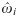
Model fit for GTEx summary statistics selects directional annotations mainly from biologically consistent cell types.Shown here are various parameter estimates from fitting 13 different GTEx eQTL summary statistics data (supplemented with GEAUVADIS eQTL data) using histone and DHS ExPecto predictions derived from Roadmap (1187 annotations). (A) BAGEA reveals the experiments underlying the directed annotations that are most predictive of gene expression. GTEx x Roadmap(Rm): Each GTEx eQTL dataset highlights particular Roadmap annotations. Shown here are the 10 largest positive effect sizes across all eQTL and annotation pairings. Effect Size: The estimate of ω^i for experiment i. (B) For each chromatin assay type, BAGEA models an assay variance modifier υ^assay-1 that expresses the extent to which that assay type is predictive of gene expression. Shown here is the distribution of the square roots of the assay variance modifier for any given assay type across all 13 GTEx eQTL datasets. Results are sorted by the maximal value achieved for each assay type and only the 10 highest scoring assay types are shown. We see that DNase.all.peaks
H3K27ac annotations dominate. The DNase.fdr0.01.peaks was prioritized in Lung tissue, which had the lowest value for DNase.all.peaks among all experiments. The highest value in DNase.all.peaks was achieved in Fibroblast, an experiment that also showed low average MSEdir.